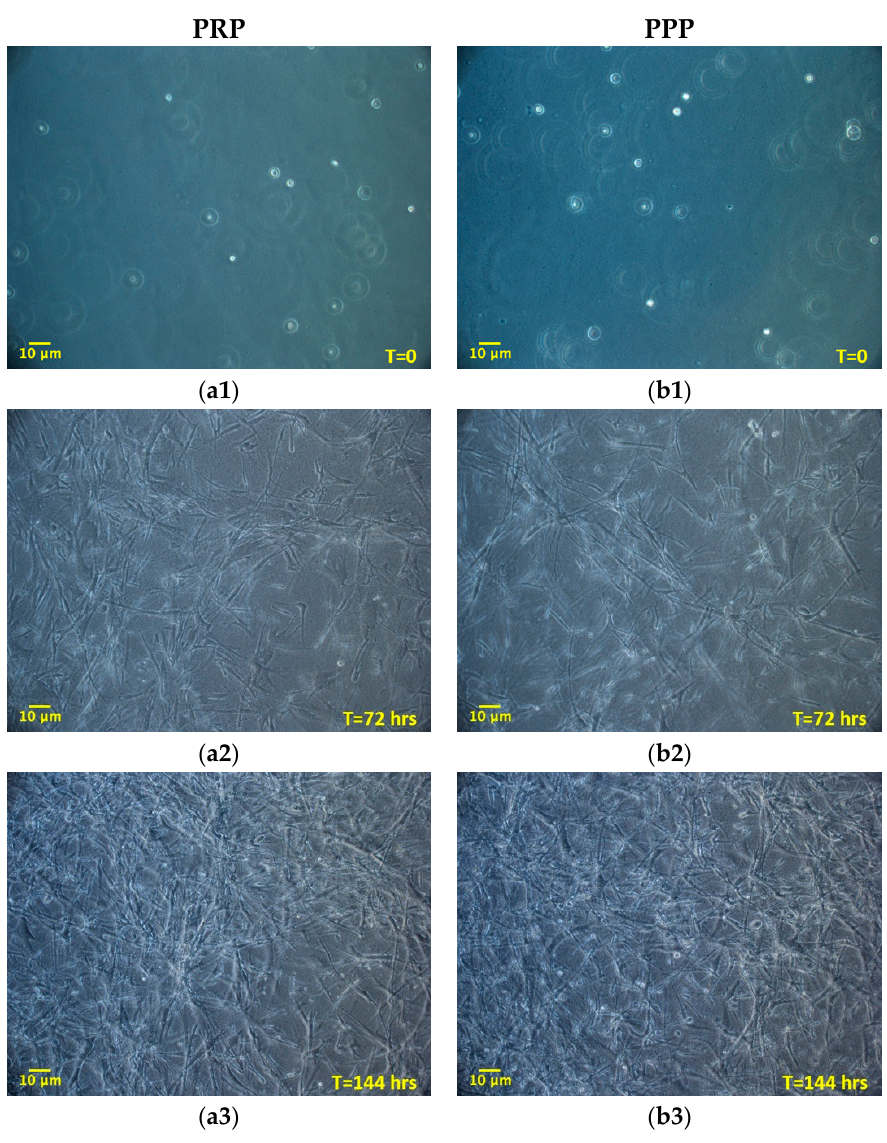
Figure 3. Morphology of ADMSCs grown inside a 3D matrix prepared from platelet-rich plasma (PRP) ( a1 , a2 , a3 ; 100 × ) or PPP ( b1 , b2 , b3 ; 100 × ), at di ff erent time points (0, 72, 144 h). The initial round-shaped morphology (a1, b1; time = 0 h), is changed in a spindle, fibroblast-like morphology at 72 and 144 h ( a2 , b2 , a3 , and b3 ). Cells gradually populate the whole 3D fibrin-derived sca ff old, spreading over the entire thickness. No morphological di ff erences are observed between cells maintained in PRP or platelet-poor plasma (PPP) derived